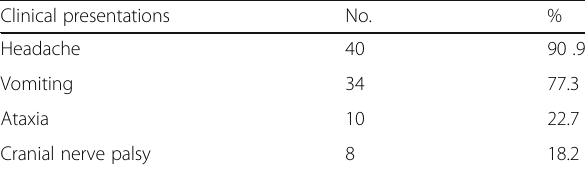
Table 1 Clinical presentation of posterior fossa tumour Clinical